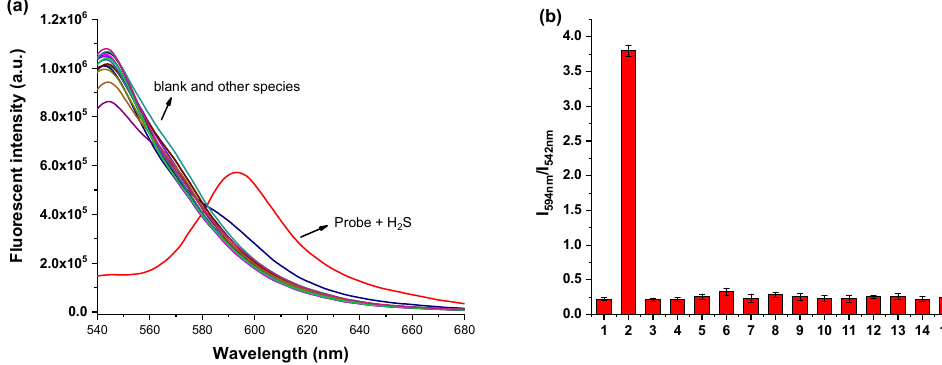
Figure 4. The fluorescence spectrum change ( a ) and intensity ratios ( b ) of probe BH (5 µ M) in the presence of various species (100 eq.) in DMSO/PBS ( v / v 1/1, pH 7.4), include 1. blank, 2. H 2 S, 3. Ala, 4. Glu, 5. GSH, 6. Cys, 7. Hcy, 8. H 2 O 2 , 9. S 2 O 32 − , 10. Br − , 11. NO 2 − , 12. SO 42 − , 13. ClO − , 14. Mg 2+ and 15. K + , recorded after 60 min.